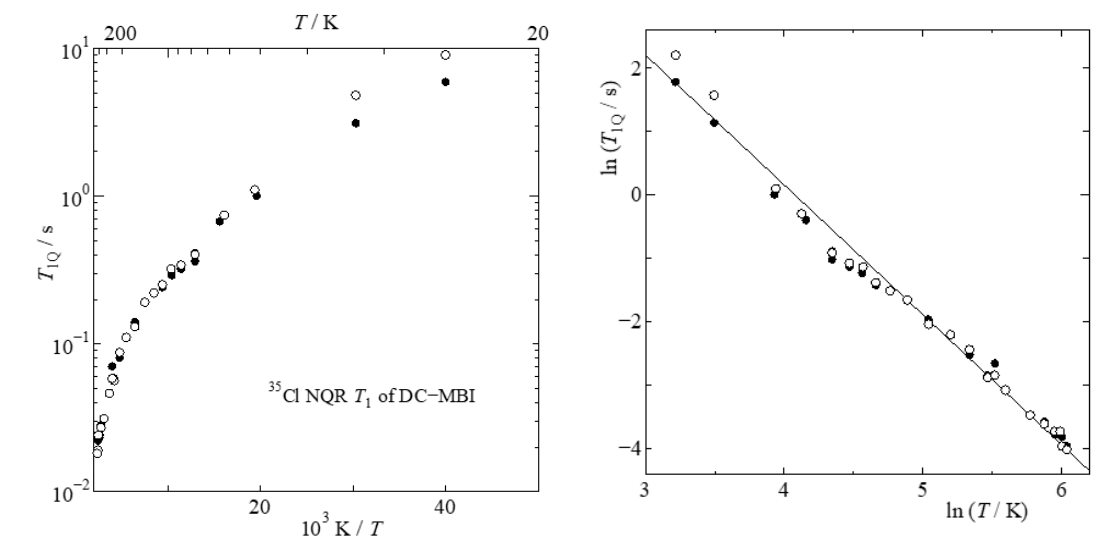
Figure 4. Temperature dependence of 35 Cl NQR spin-lattice relaxation time T 1Q of DC-MBI. Data shown by solid and open circles are of the frequencies shown by the same symbols in Figure 3, respectively.